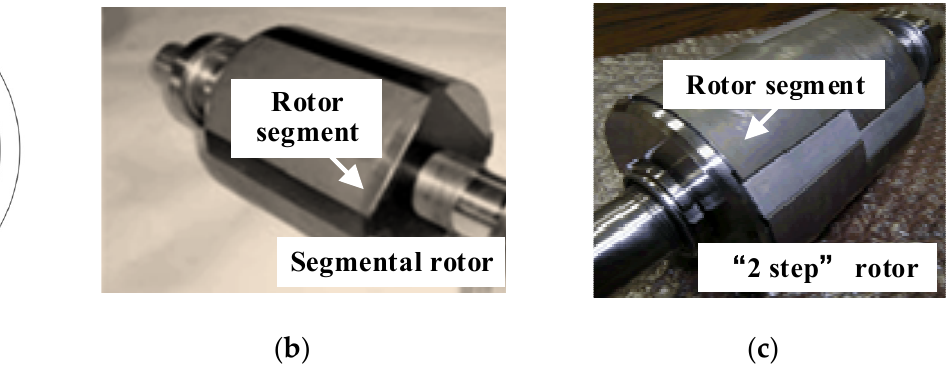
Figure 4. Proposed 6/4 SSRM with FPW. ( a ) is the topology of the proposed SSRM (the blue area is segmental rotor); ( b ) and ( c ) depict a segmental rotor and a “2-step” rotor, respectively.